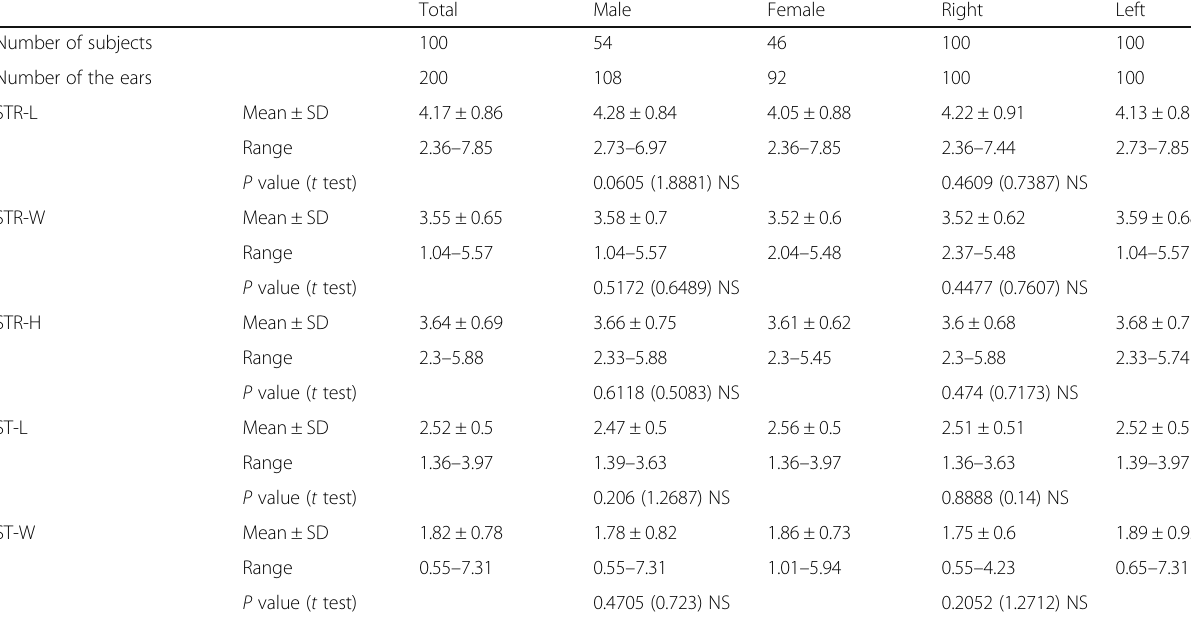
Table 1 Analysis of the STR and ST measurements using mean ± SD and range (in millimeter)